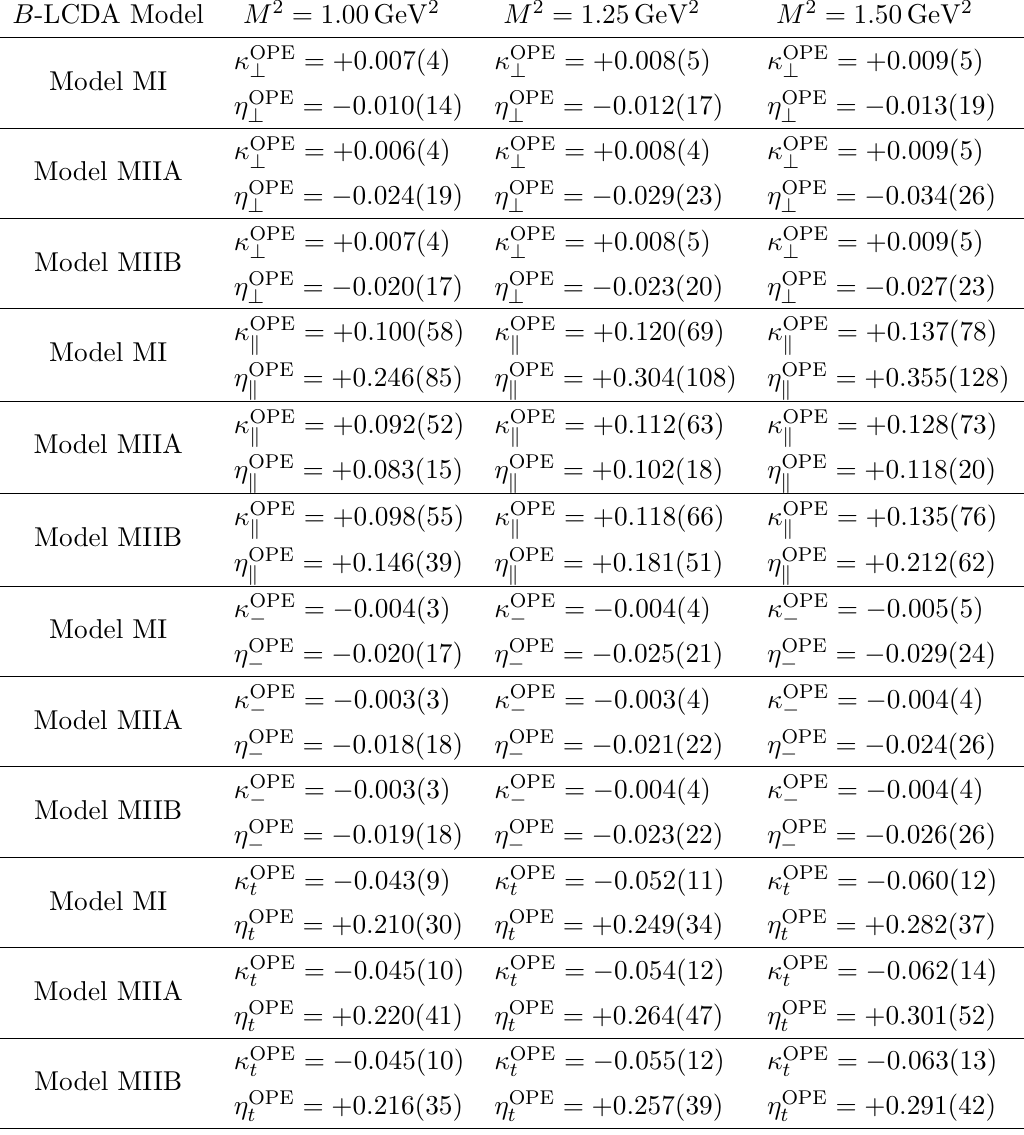
Table 9 . Results for the OPE coe(cid:14)cients in the z -expansion of vector, axial-vector and timelike- helicity form factors in the three di(cid:11)erent models considered for B -meson LCDAs. this matrix is given